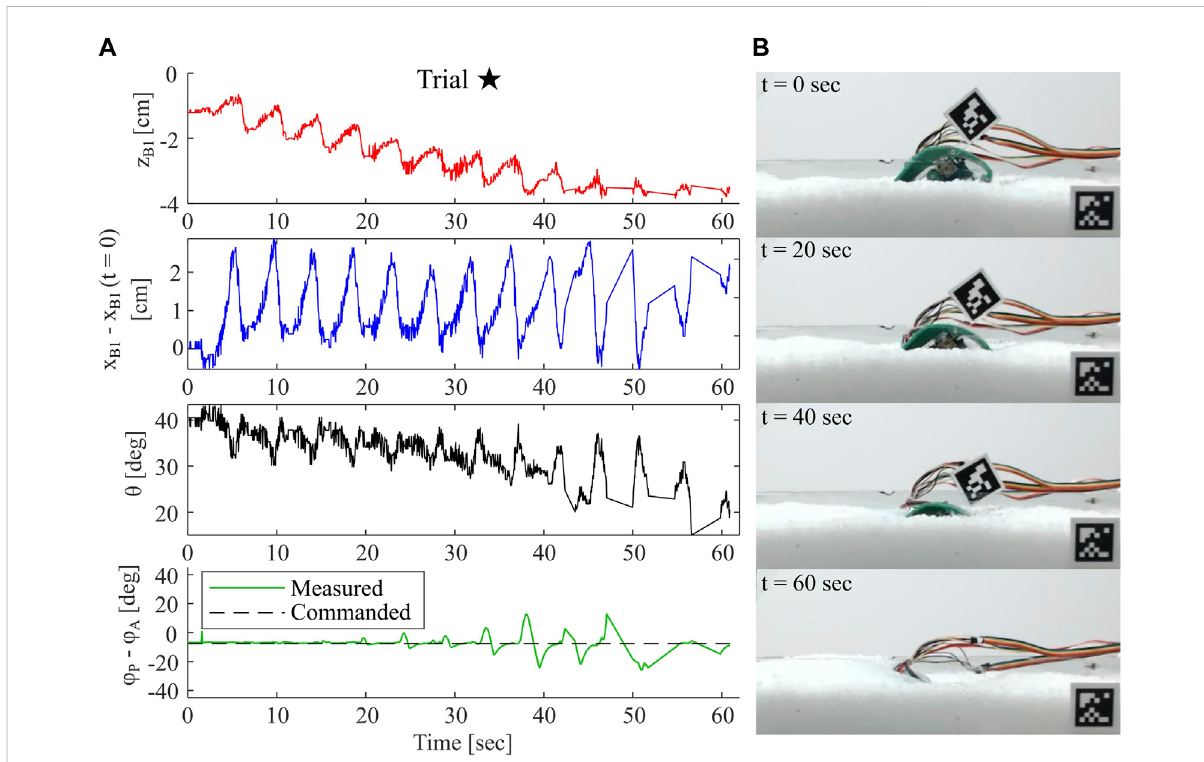
FIGURE 12 Example of Successful Robot Burrowing Sequence. (A) Plots of depth measured relative to substrate surface, horizontal position relative to initial position, sagittal plane body pitch, and measured phase lag between leg pairs throughout a single burrowing sequence (B) Images of robot during the corresponding burrowing sequence, with timepoints